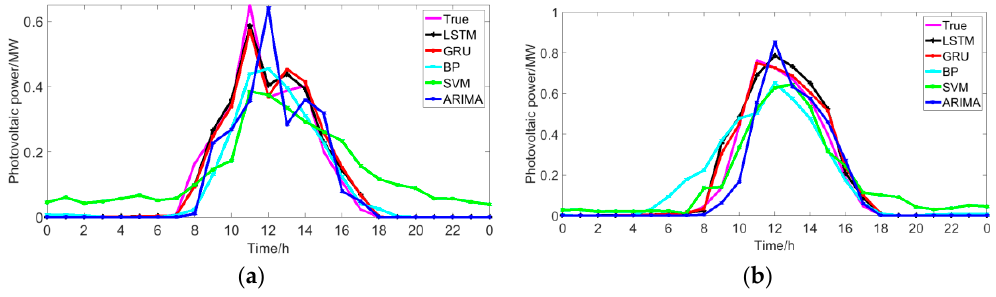
Figure 10. The real photovoltaic power and forecasted photovoltaic power selected from validation set randomly. ( a ) Photovoltaic power of 21 April 2014; ( b ) Photovoltaic power of 17 May 2014.